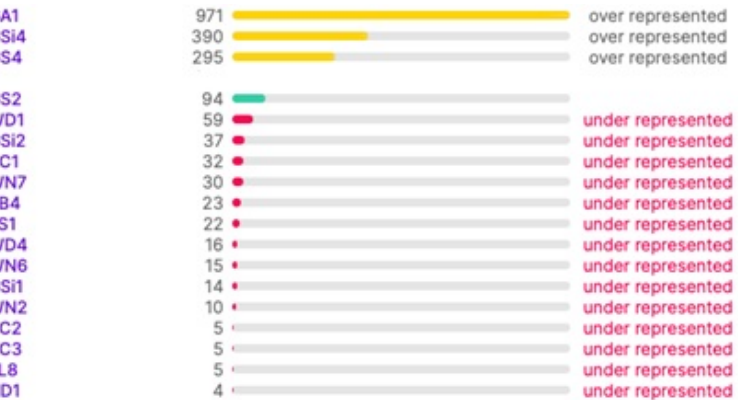
Figure 3. Class Balance between Habitat Types.